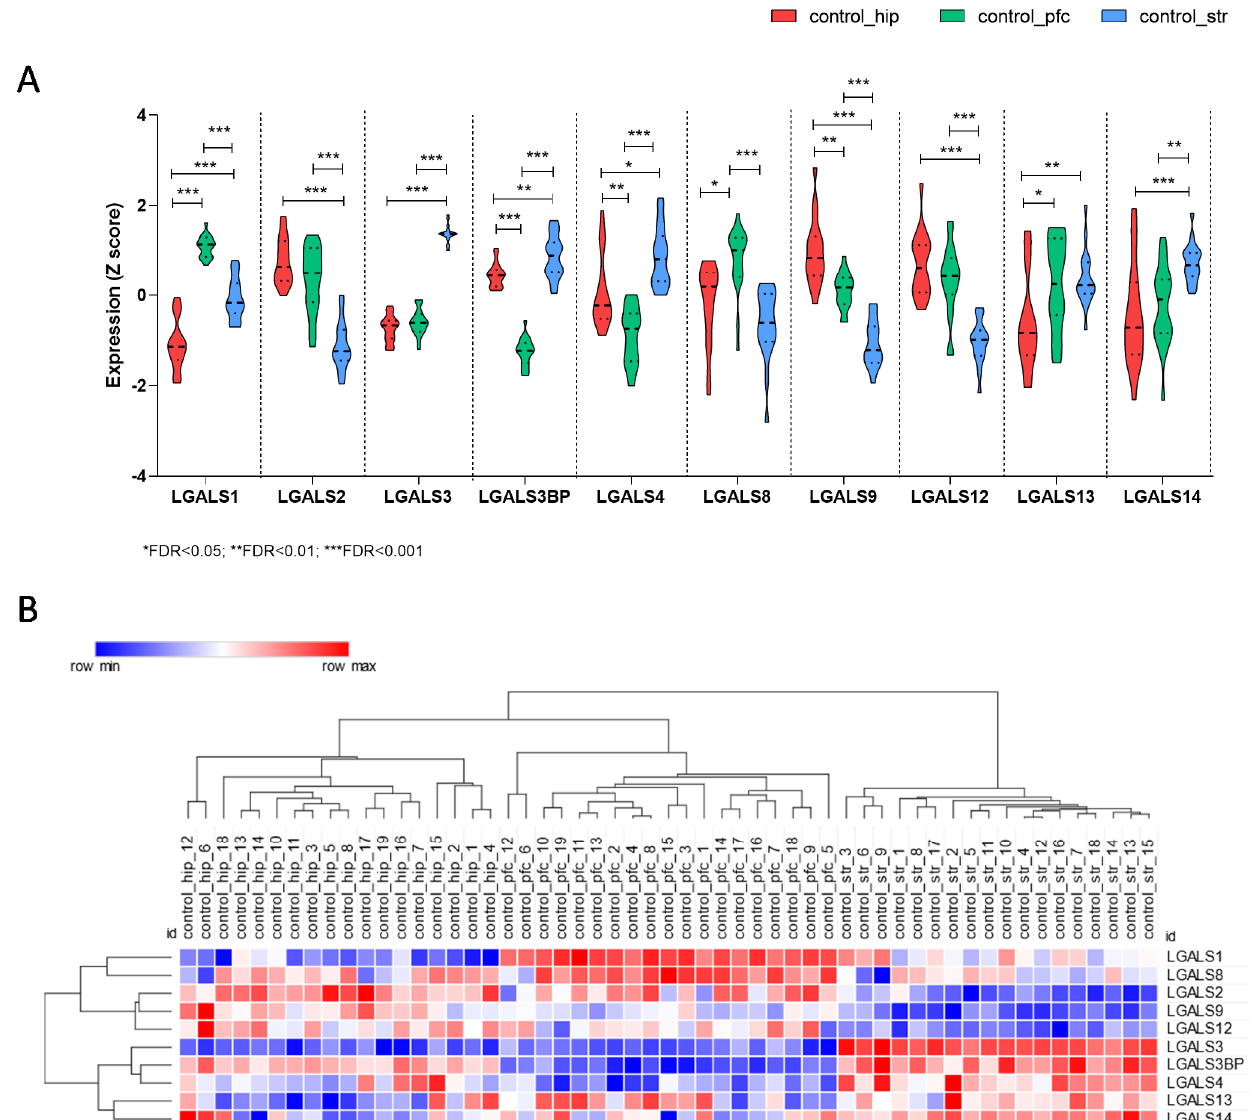
Figure 1. Expression levels of the galectin gene family members in the normal brain. The expression levels of the members of the galectin gene family were determined by interrogating the GSE53987 dataset. ( A ) Violin plots showing the expression levels of the galectin genes in the hippocampus, prefrontal cortex, and striatum of normal donors. ( B ) Hierarchical clustering for the expression levels of the galectin genes; the hippocampus, prefrontal cortex, and striatum of normal donors were calculated using the Spearman rank correlation as similarity metrics.